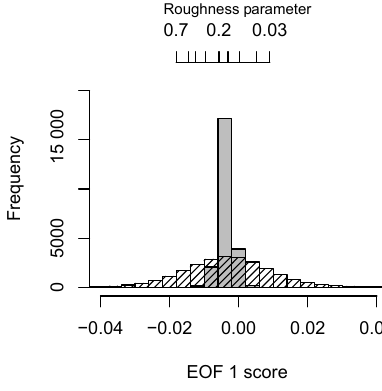
Figure 10. The distribution of inferred EOF 1 scores for synthetic data with and without noise. The distribution for the noise-added synthetic data are symmetric about the EOF 1 score corresponding to the true roughness. The median of EOF 1 score is − 0.00336, corresponding to roughness parameter of σ 2 = 0 . 14.